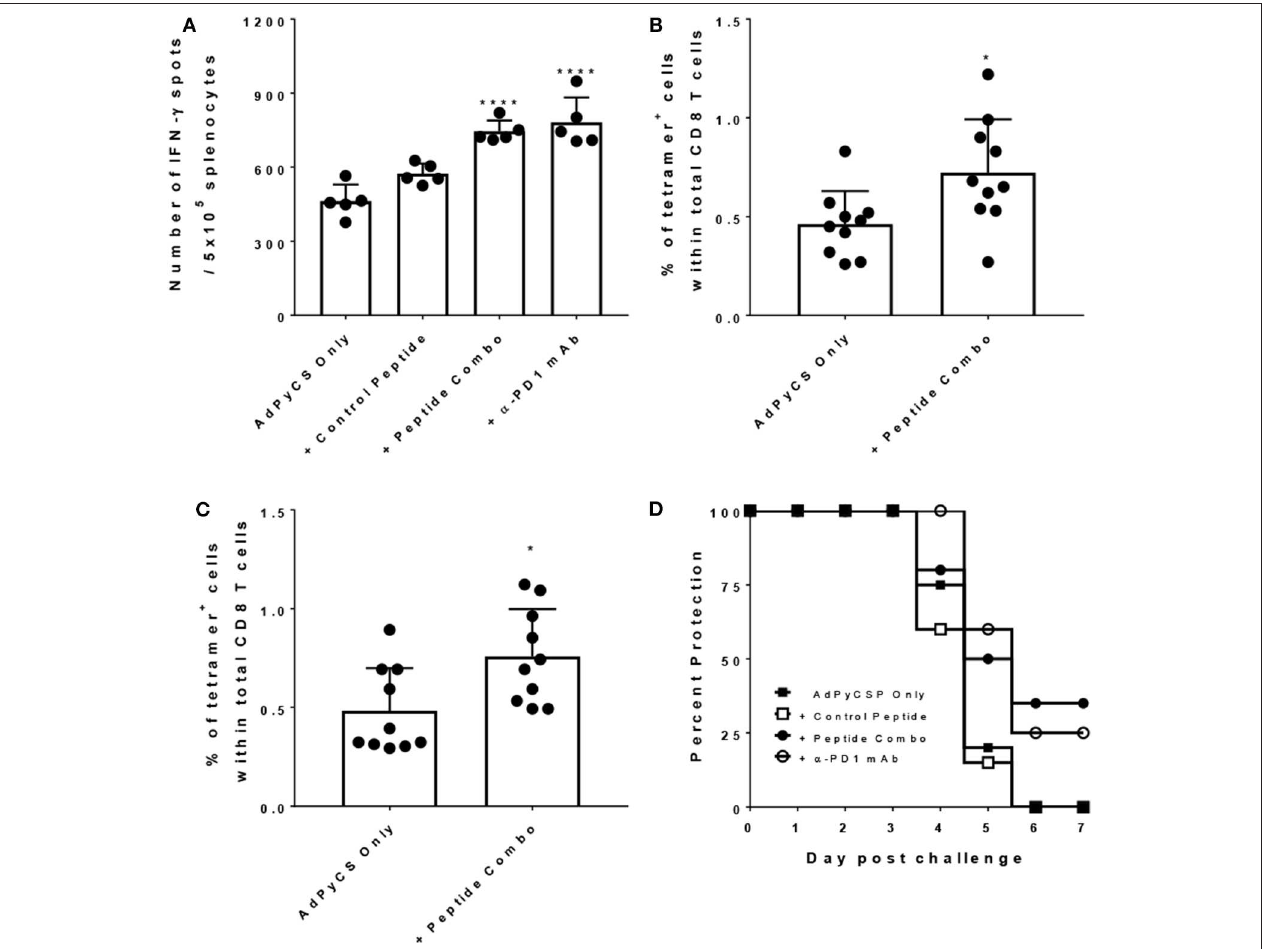
FIGURE 7 | Increased CD8T cell immunogenicity and efficacy following treatment with PD1 peptide antagonists. (A) At day 12 post-immunization, immunogenicity was assessed by measuring the number of splenic CS-specific, IFN- γ -secreting CD8T cells using the ELISpot assay after stimulation with the H-2kd restricted CD8 epitope SYVPSAEQI. The control peptide is the OVA 323 − 339 peptide. Data are expressed as the mean ± SD. Significant differences between AdPyCS alone and treated mice were determined using a one-way ANOVA multiple comparisons test, which are denoted by **** p < 0.0005. (B) On day 4 and (C) day 9, post-immunization splenocytes from mice were stained directly ex vivo for CD3, CD8, and SYVPSAEQI-specific tetramer and analyzed by flow cytometry. Data are expressed as the mean ± SD. Significant differences between groups were determined using unpaired two-tailed t -tests, which are denoted by * p < 0.05. (D) Immunized and treated mice ( n = 20/group) were challenged with Py 17XNL sporozoites IV. Data represent 2 independent experiments ( n = 10/group) and are expressed as the mean percent protection. Parasitemia was assessed beginning on day 3 post-challenge and protection was defined as the absence of parasite detection in the blood by microscopic examination of Giemsa-stained thin